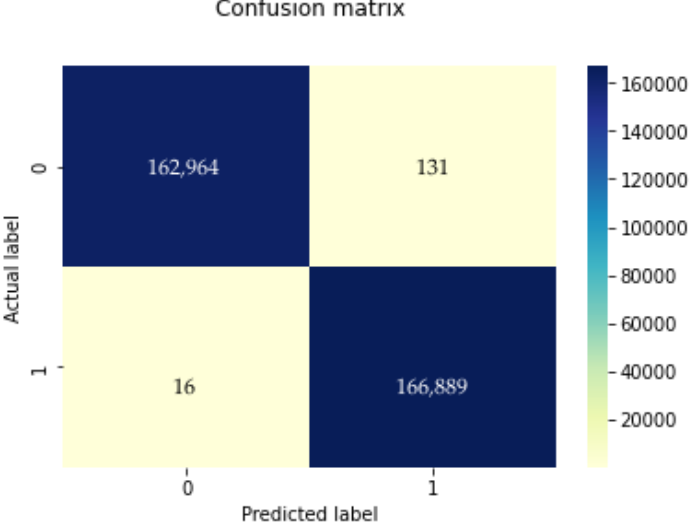
Figure 26. Increasing the DDoS dataset confusion matrix.